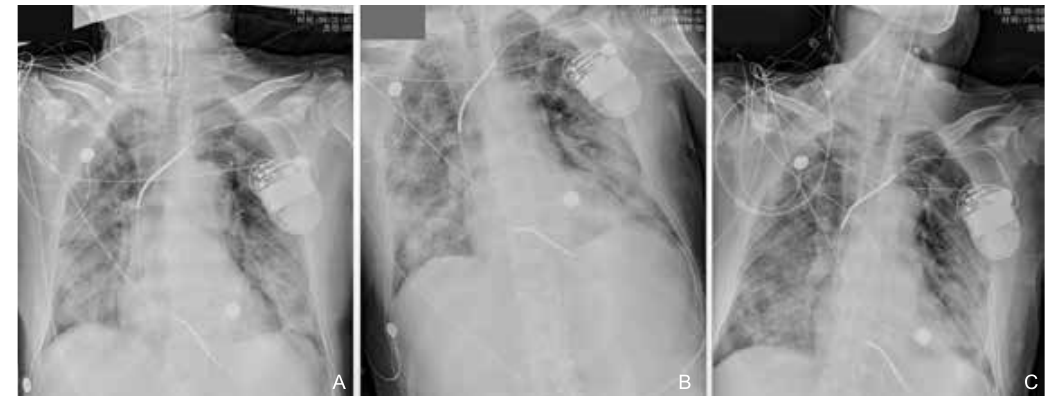
Figure 2 A progressive stage case plain films of an 80-years old male hospitalized patient, 5 days after disease onset. (A) Increased patchy density mainly distributed in the middle and lower fields of both lungs. (B) On the second day, the number and size of the lesions were approximately similar to the first radiograph with slightly increased density; (C) On the 4th day, the image showed a reduced number and size of the lesions with reduced density in the right lower